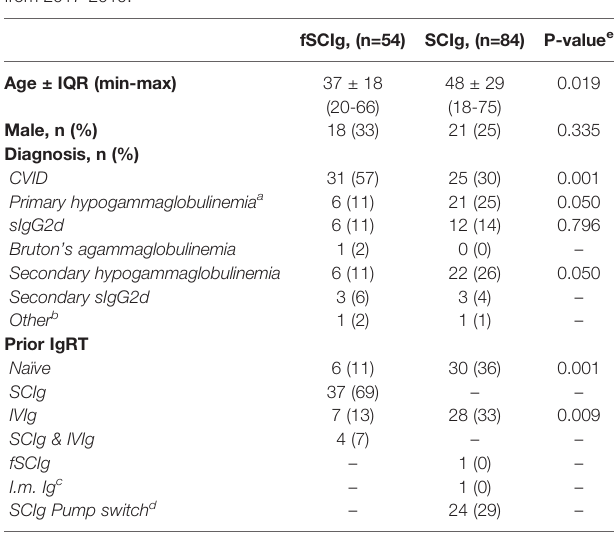
TABLE 1 | Characteristics for patients that underwent fSCIg or SCIg training from 2017-2019.